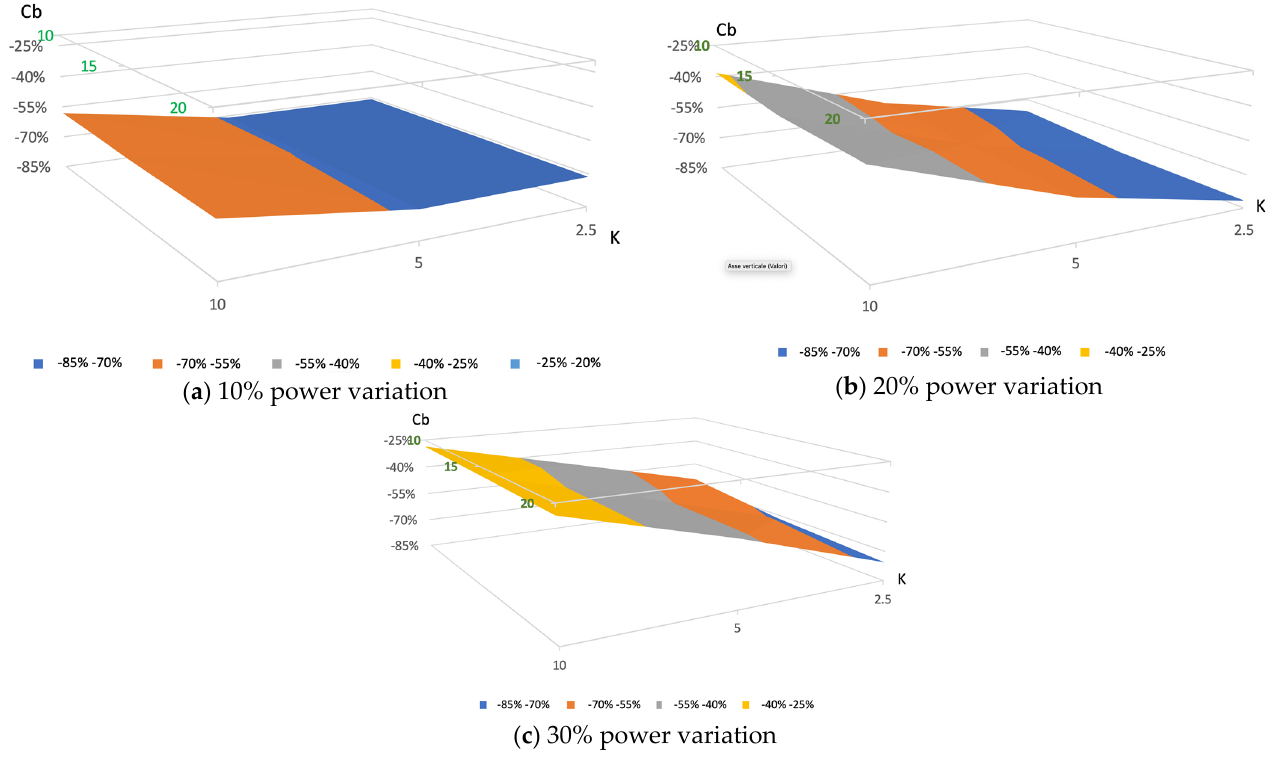
Figure 4. Energy over peak power.